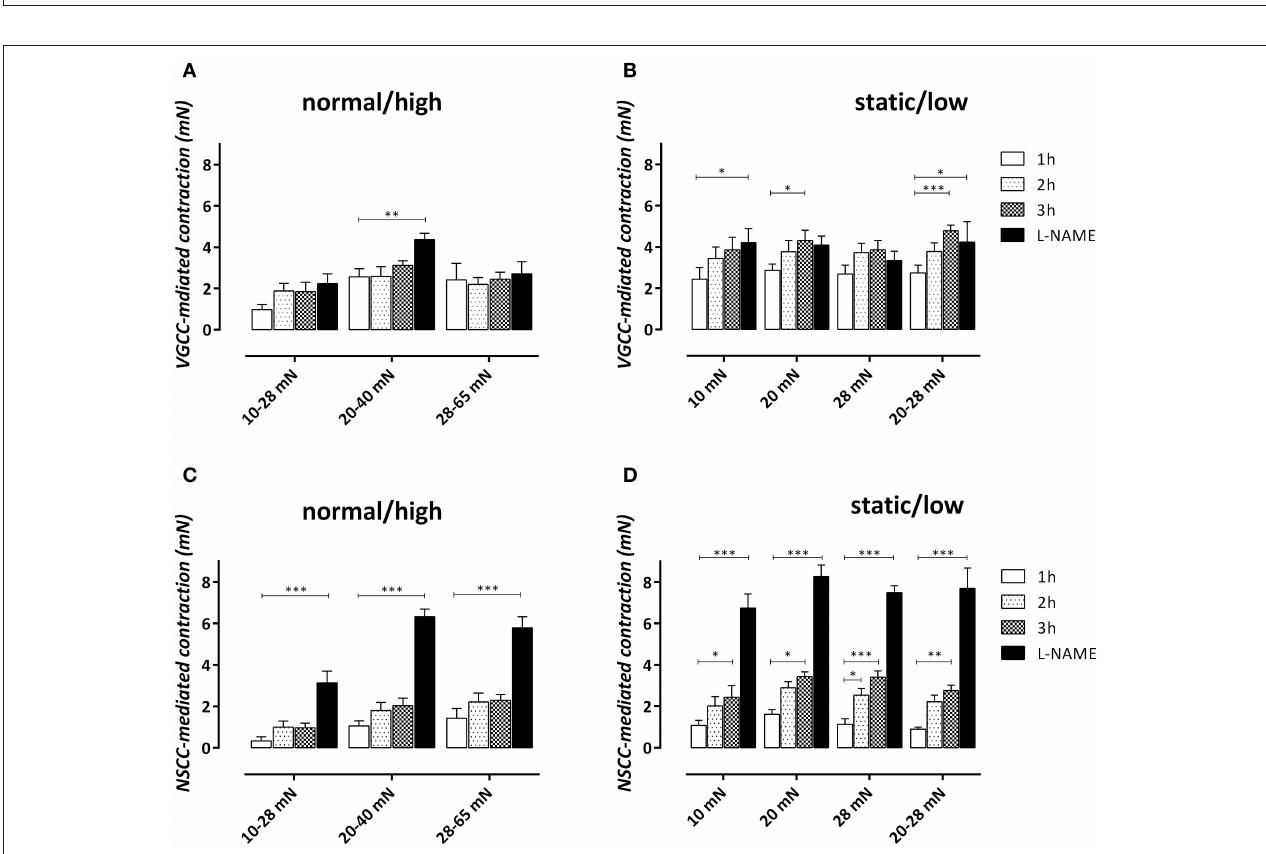
FIGURE 7 | VGCC (A,B) - and NSCC (C,D) -mediated contractions by 2 µ M PE in aortic segments subjected to cyclic stretch of normal/high amplitude (A,C) or static/low cyclic stretch (B,D) determined after addition of 35 µ M diltiazem at 1, 2, and 3h after mounting. After 4h, 300 µ M L-NAME was added to determine the maximal VGCC- or NSCC-mediated contraction by inhibiting relaxing NO release. * P < 0.05, ** P < 0.01, *** P < 0.001 vs. 1h. n = 5–6, one-way ANOVA with Dunnett’s multiple comparison